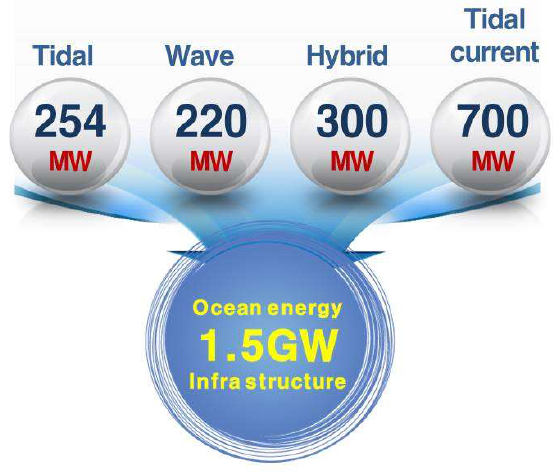
Figure 3. The target installed capacity of ocean energy by 2030 [10,11].